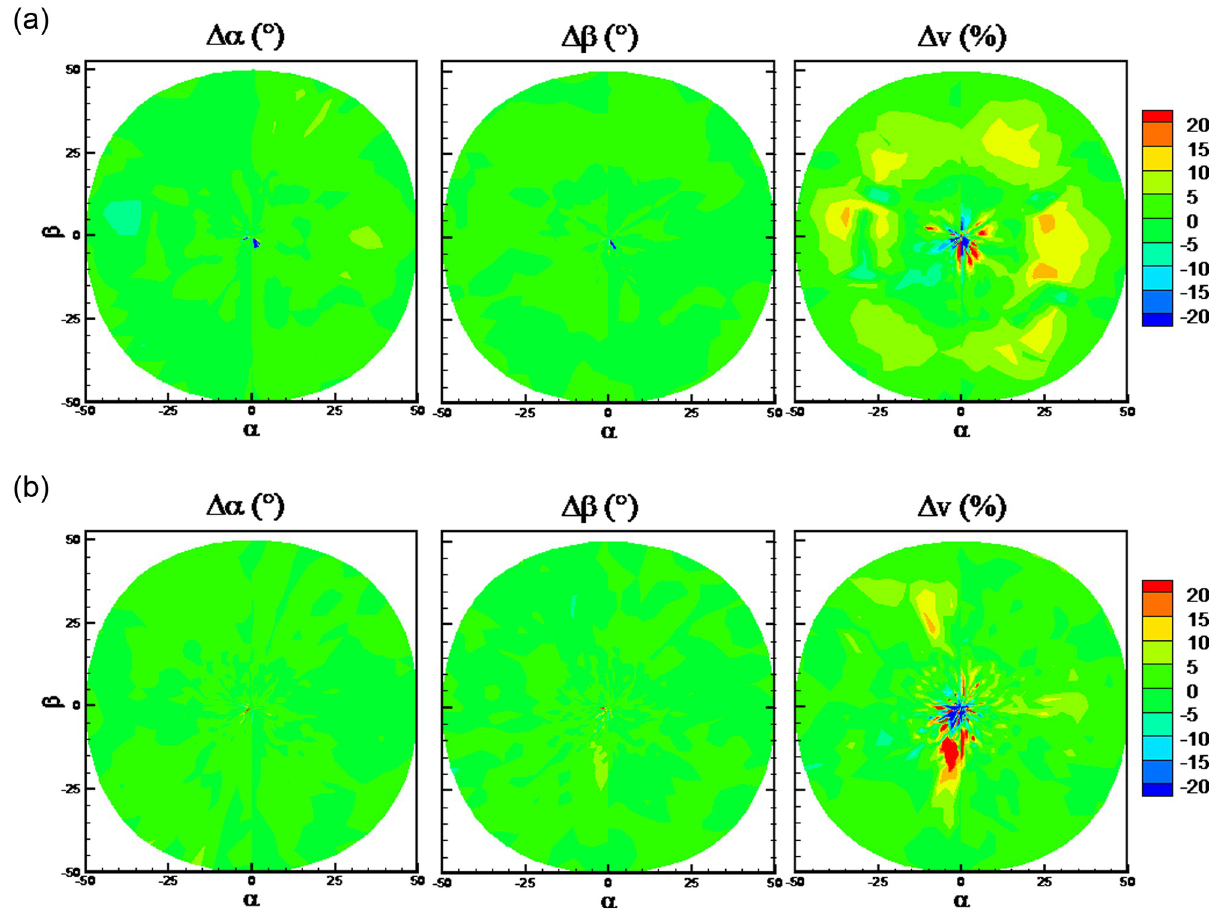
Fig 27. Error distributions when port 7 is invalid. a) Poly algorithm, b) traditional